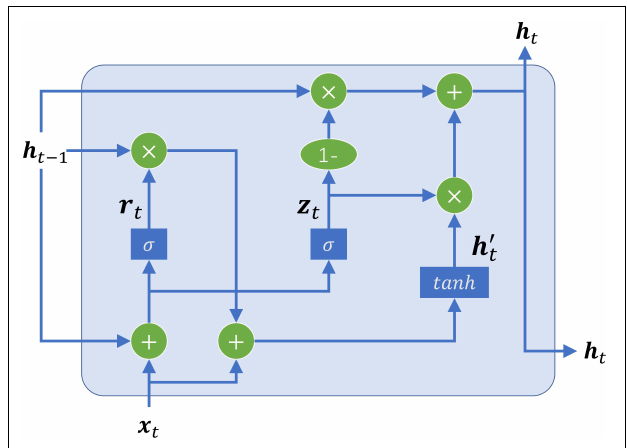
FIGURE 2 | The structure of GRU cell. There are two gates, including a reset gate (denoted as r t ) and an update gate (denoted as z t ), to control the information flowing in and out of the cell. The reset gate control how much of the previous information to store. The update gate control how much of the past information needs to be passed along to the next time step. x is the embedding matrix of the input subsequence, h is the output of the GRU cell, and t denotes the t -th time